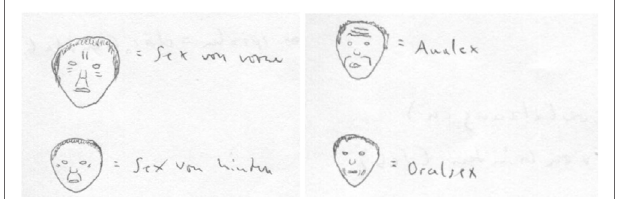
FIGURe 1 | the meaning of different wrinkles . Top left: sexual intercourse from the front; top right: anal sex; lower left: sexual intercourse from behind; lower right: oral